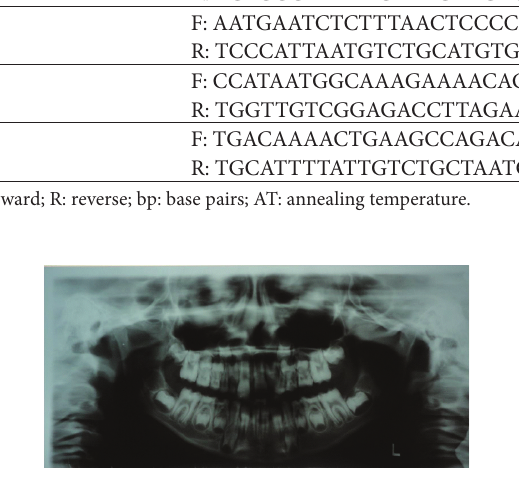
Figure 4: Panoramic radiograph showing that the thin enamel layer could not be distinguished from the underlying dentin.